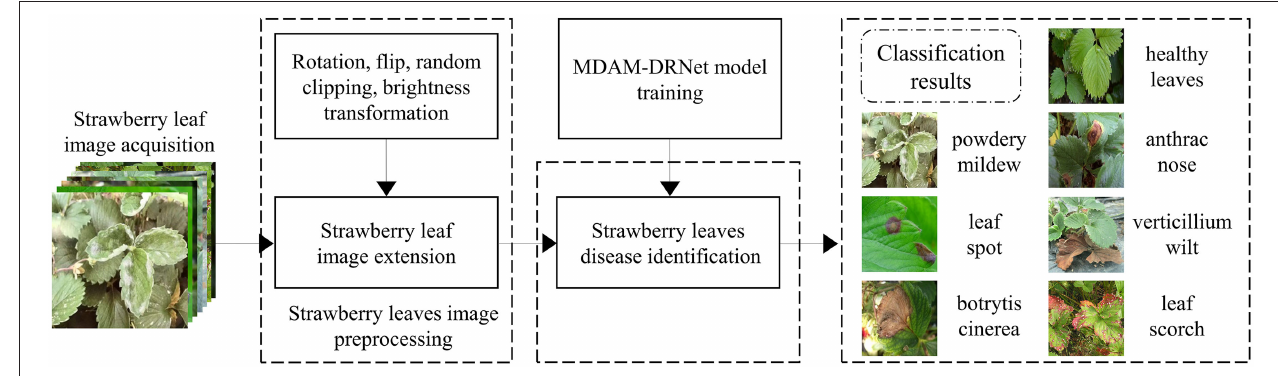
FIGURE 1 | Schematic diagram of strawberry leaves disease identification.